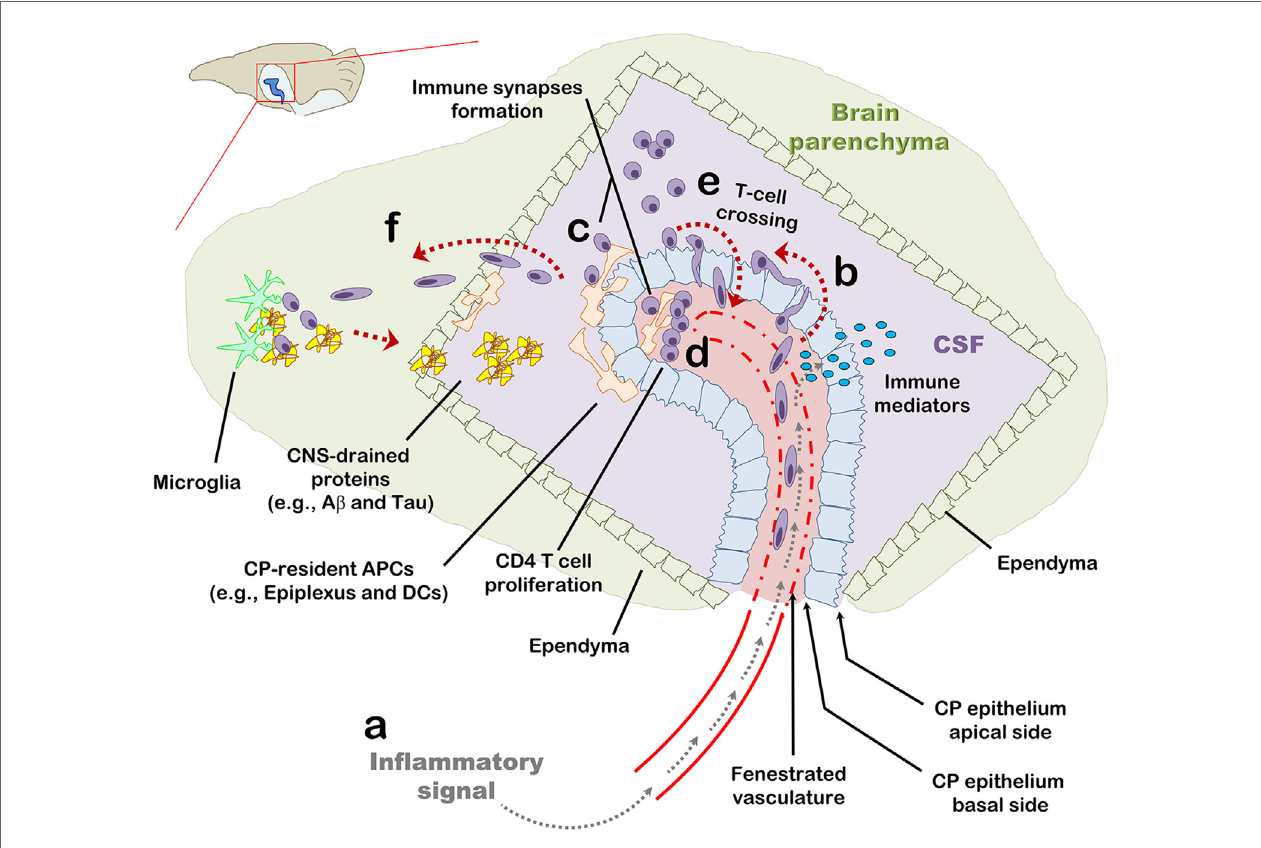
FigUre 6 | The choroid plexus (CP) as a checkpoint for cell-mediated immunity in the central nervous system (CNS): a suggested model. The CP manufactures most of the cerebrospinal fluid (CSF) and serves as an interface between the blood and the CNS. (a) The CP primarily comprises a fenestrated vasculature, a stroma, and epithelial, whose apical surfaces face the CSF. Inflammatory signals such as IL-1 β and tumor necrosis factor activate the CP vasculature and epithelium and induce immune signaling in the CP compartment. (B) As part of this inflammatory reaction, peripheral blood effector and/or memory T cells are recruited to the CP stroma and into the CSF. (c,D) Antigens in the CNS, either self or foreign, which drain into the CSF, are sampled by antigen-presenting cells and presented to CD4 T cells which, thereby, undergo activation and migrate into the CNS parenchyma. (e) Intercellular adhesion molecule 1 and chemokines strongly upregulated at the apical surface of the CP epithelium allow T cells in the CSF to adhere the CP and cross its epithelium back into the CP stroma. (F) Activated CD4 T cells further facilitate cell-mediated immunity in the CNS by preconditioning the CNS for cell migration across the ependymal layer of the ventricle and/or across the parenchymal and meningeal CNS vasculature. T-cell activation in the CP compartment, may not only serve as a checkpoint for cell-mediated immunity in the CNS but also impact the immune network required for brain functioning and repair at